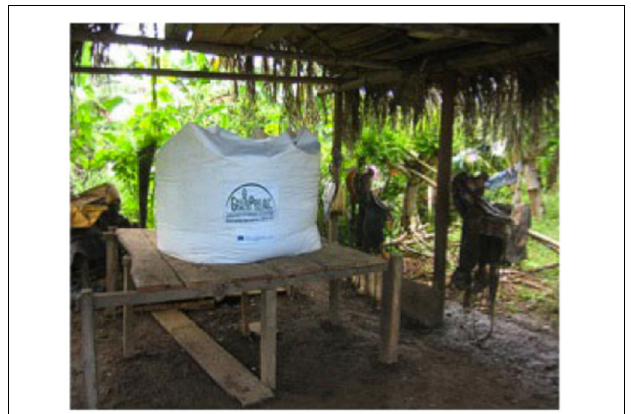
FIGURE 8 | Collapsible solar dryer in